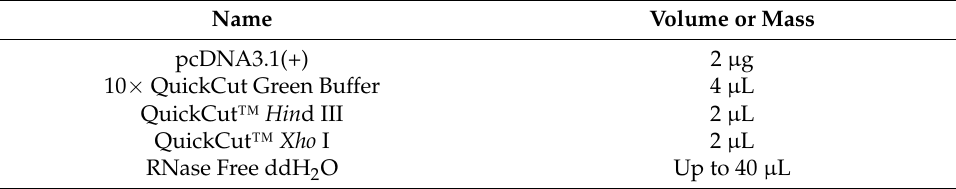
Figure 2. pcDNA3.1(+) illustration. Table 2. Enzyme digestion system. Table 2. Enzyme digestion